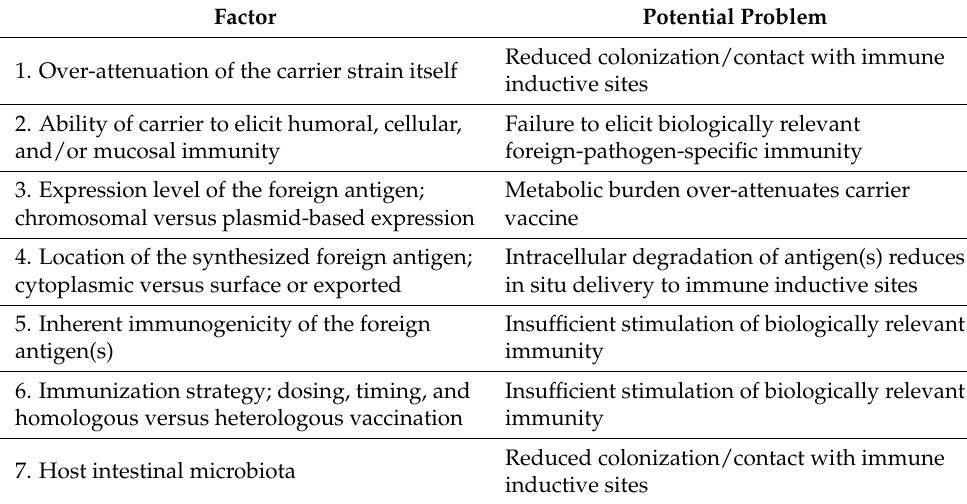
Table 2. Factors potentially affecting foreign-antigen-specific immunogenicity of attenuated S. Typhi- based oral carrier vaccines in